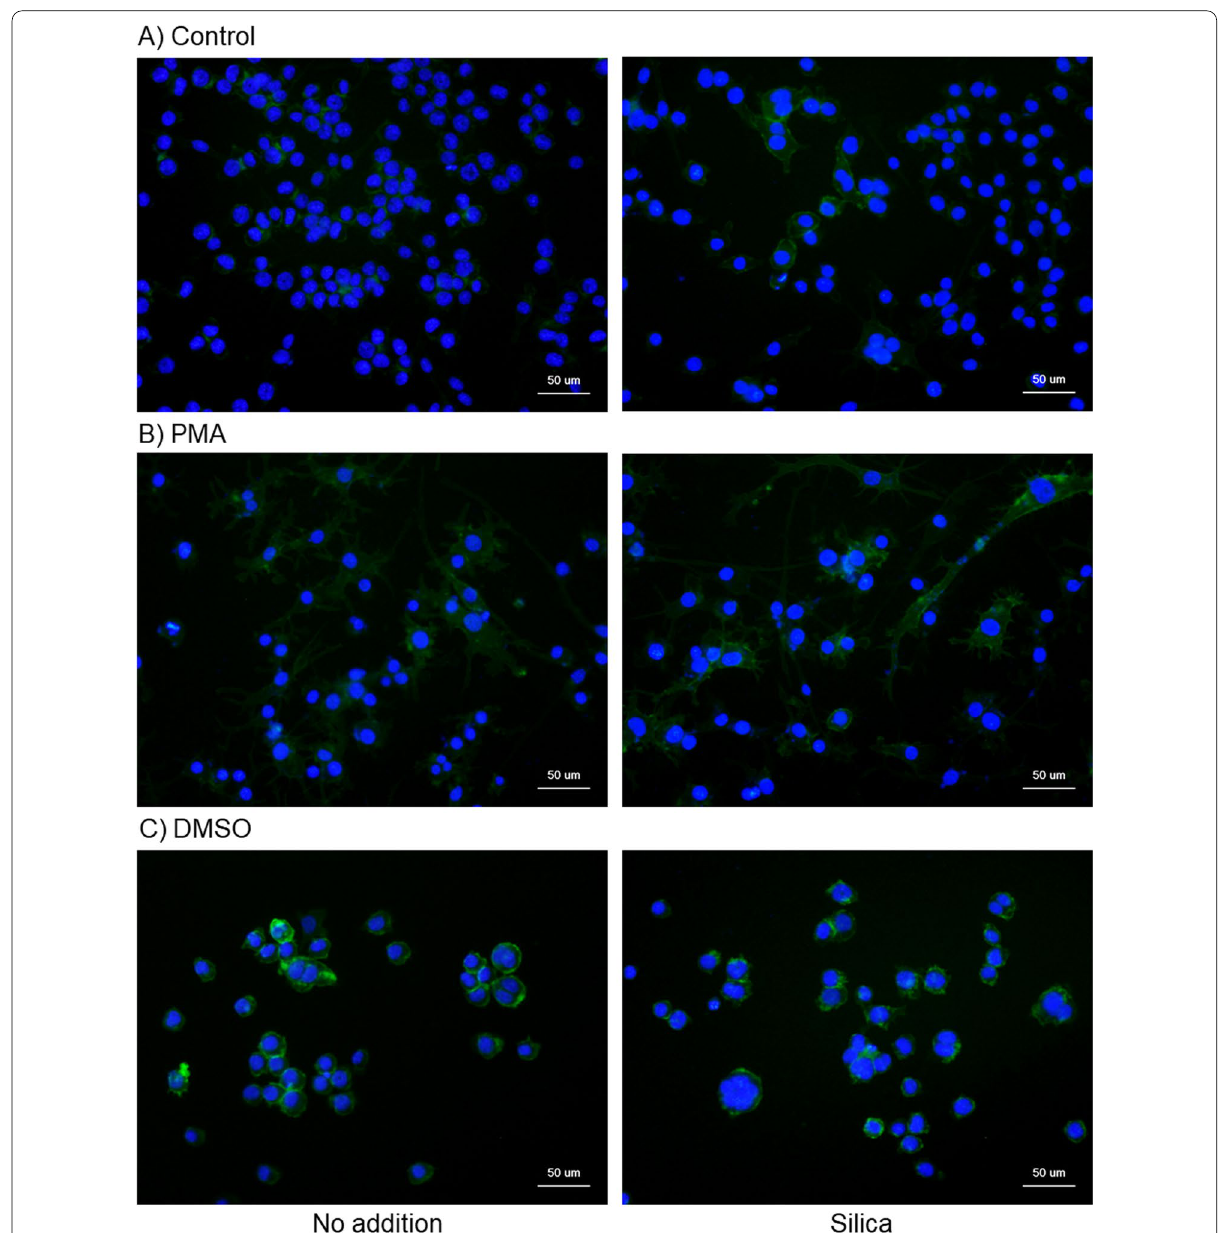
Fig. 6 Effects of silica microparticles (MPs) on CD11b expression in control A and phorbol 12-myristate 13-acetate (PMA)- B and DMSO-treated HL60 cells ( C ). These cells were simultaneously treated with silica MPs for 3 days. The cells were then fixed and subjected to immunocytochemical CD11b staining followed by DAPI staining. Similar data were obtained from two additional independent experiments ( n indicate the presence of CD11b and nuclei,